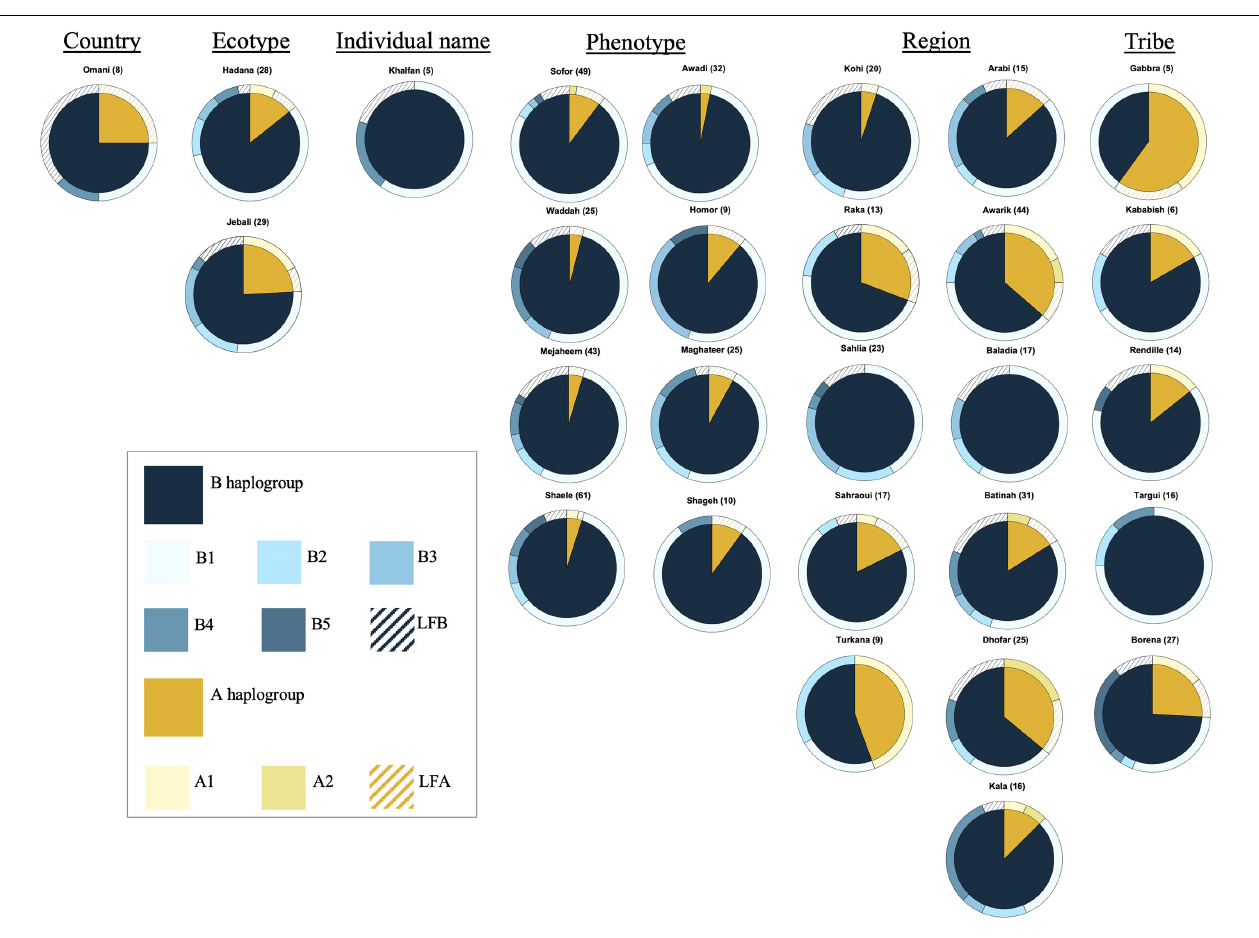
FIGURE 4 | Frequencies of haplotypes of different camel-types grouped according to their naming criteria. Camel-types represented by < 5 individuals were not plotted. Camel-types with unknown naming system are not